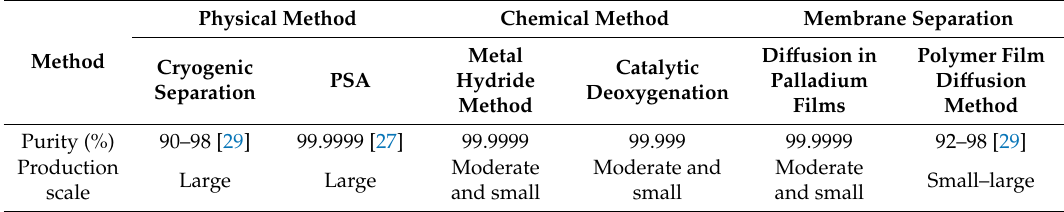
Table 6. Characteristics of several hydrogen purification methods. PSA, pressure swing